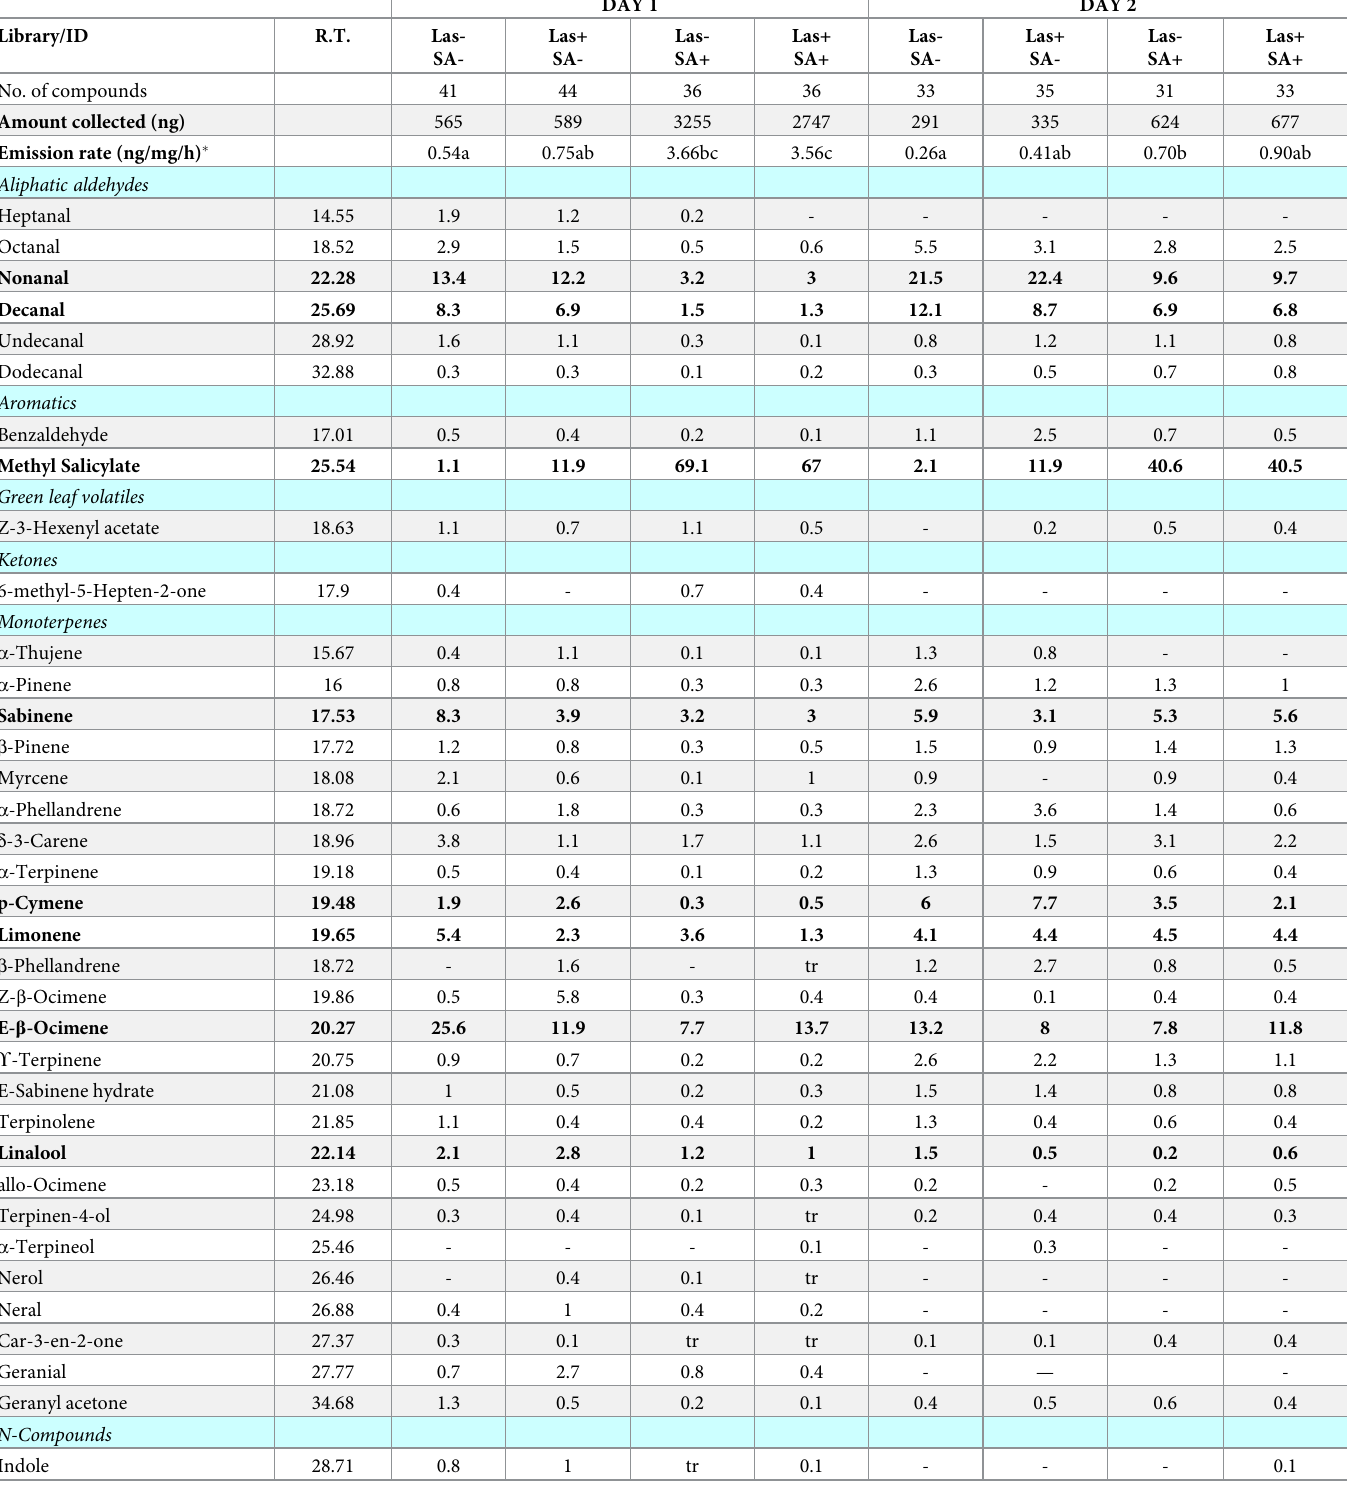
Table 2. Salicylic acid experiment results showing mean absolute amounts, emission rates, and relative proportions of volatile compounds in headspace samples collected on two consecutive days from Valencia sweet orange (infected with Las or uninfected; treated with salicylic acid or Tween-treated). DAY